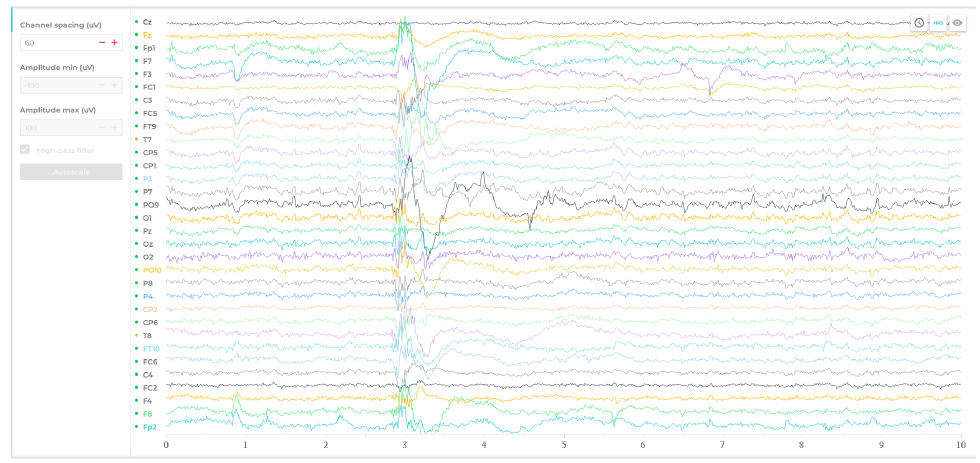
Figure 13. An example of a nervous tic involving the neck muscle tightening.